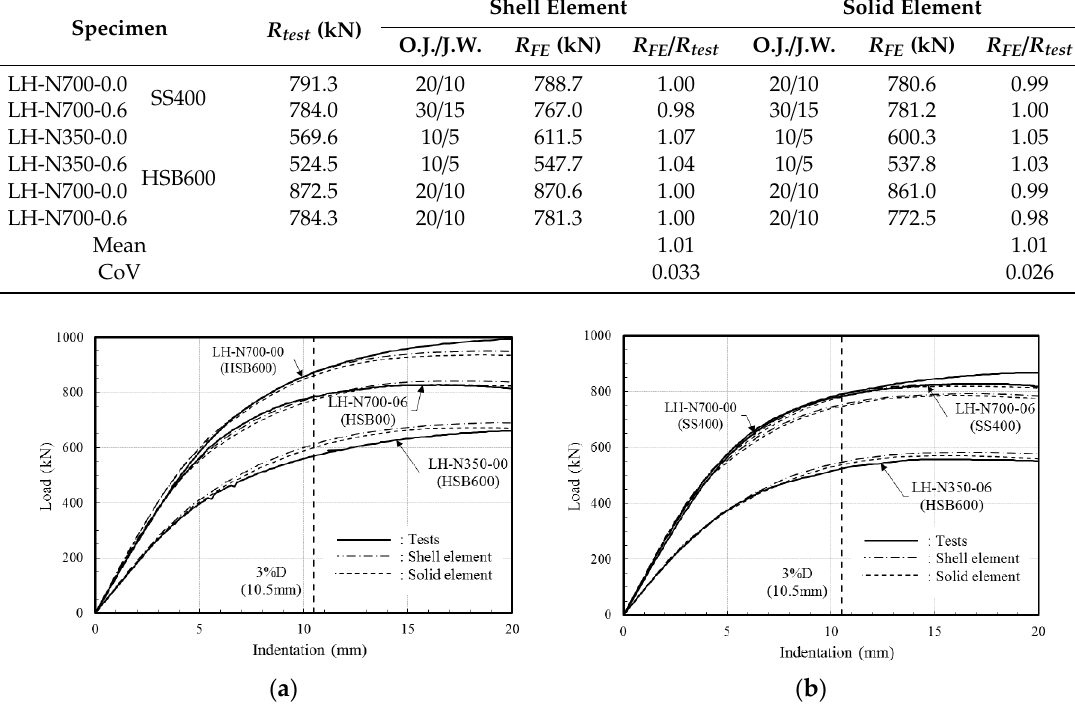
Figure 4. Load–indentation curves of test and finite element (FE) models: ( a ) HSB600; ( b ) HSB600 and SS400. Table 5. Comparison of joint strength. CoV—coefficient of variation.